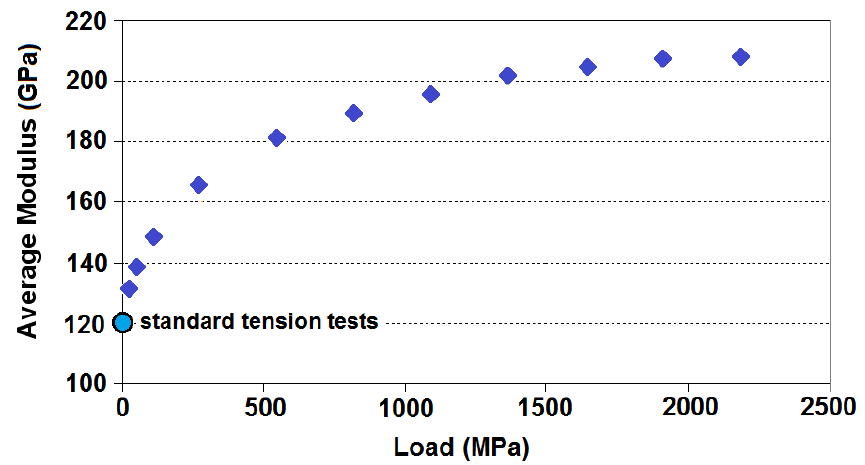
Figure 8. Young’s modulus measured at the various pretension loads and averaged over various impact velocities.